Question: Summarize what this figure shows in one sentence.
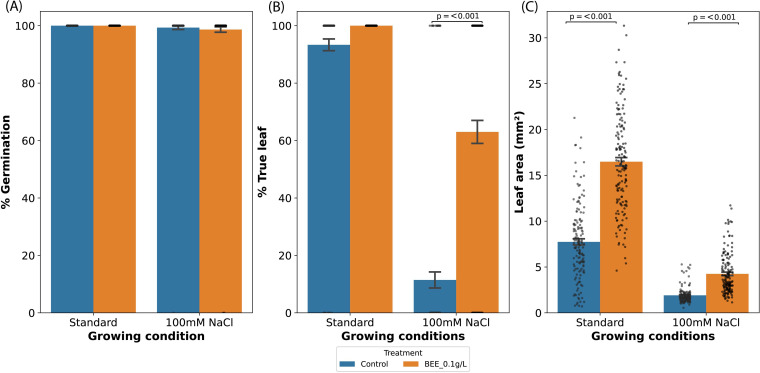
Answer: Growth parameters of Arabidopsis treated with BEE under standard and 100 mM NaCl growth conditions. Shown are the effects on germination rate (A) , true leaf emergence at 6 DAS (B) , and leaf area at 10 DAS (C) . p -values indicate significant differences (p < 0.05, n = 150) between control and BEE treatment in respective groups (growth condition) according to two-way ANOVA followed by Tukey’s HSD test.